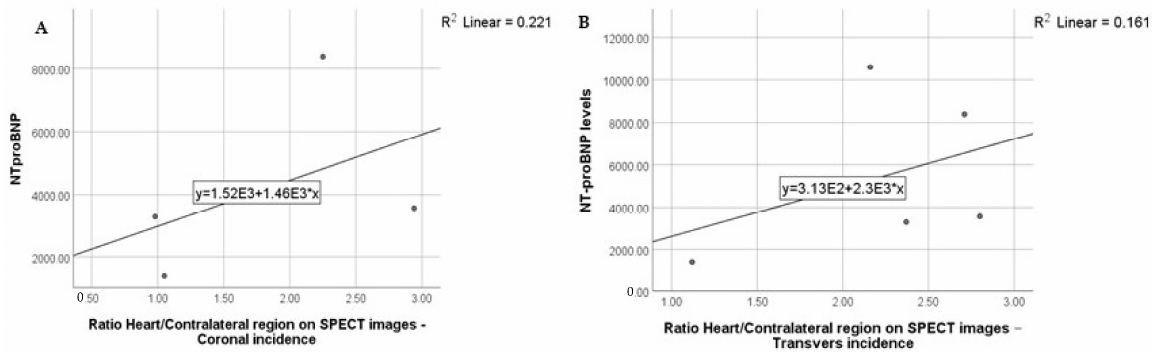
Figure 4. NT-proBNP levels in relation to the Heart/Contralateral region on SPECT images (Coronal incidence—( A ); Transvers incidence—( B )) ratio results.